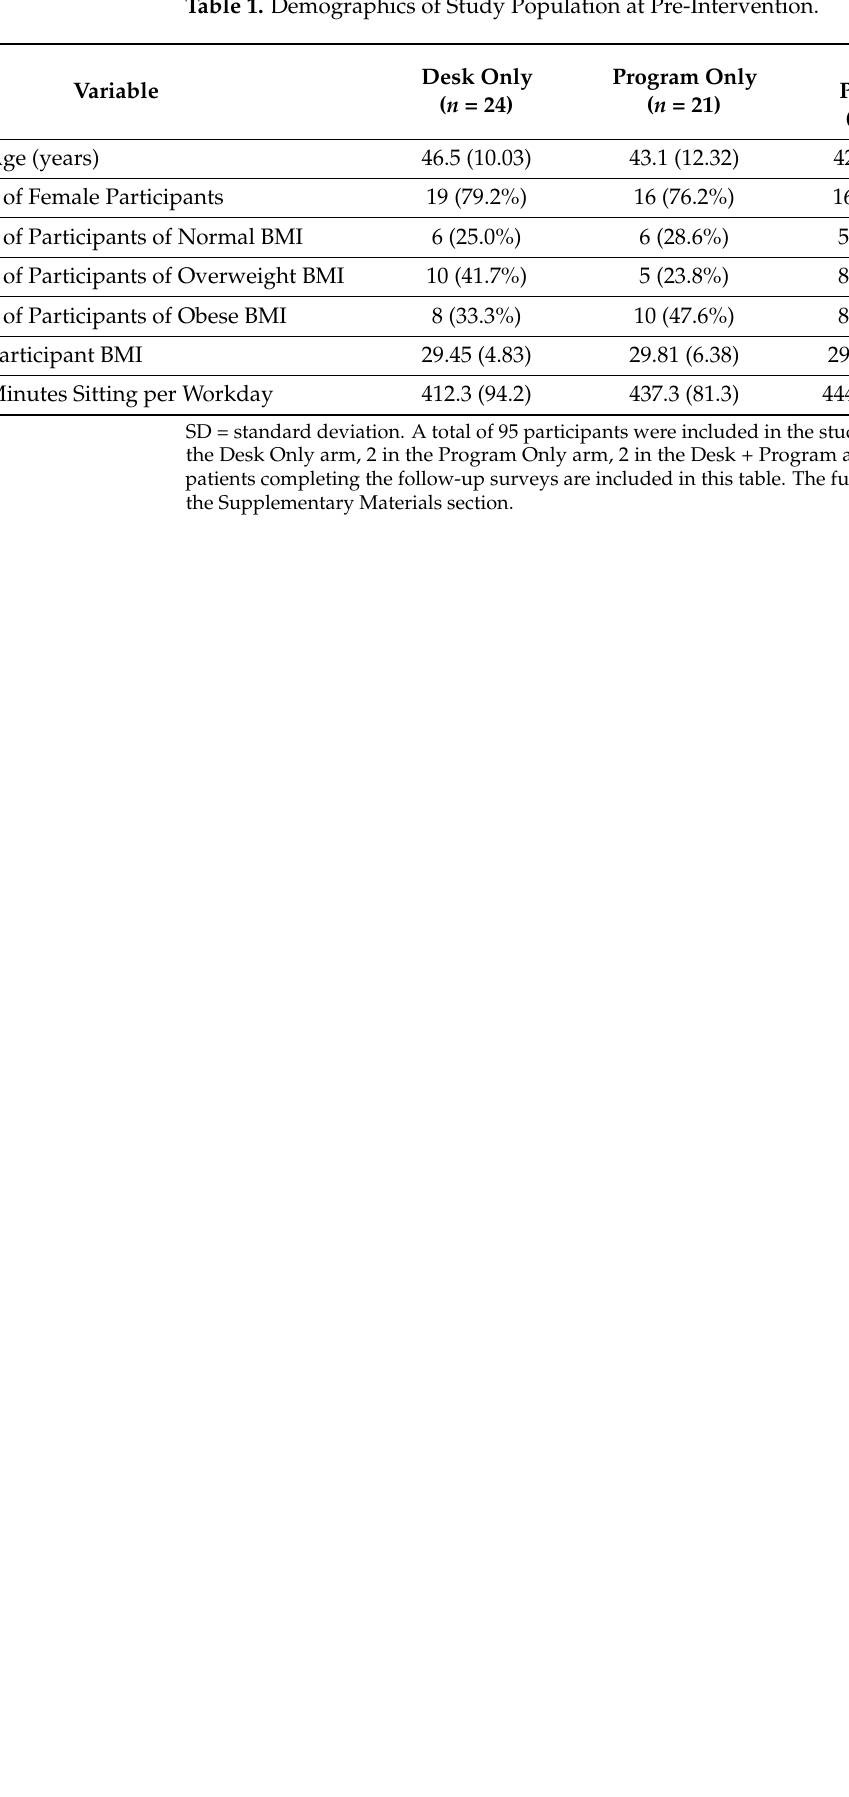
Table 1. Demographics of Study Population at